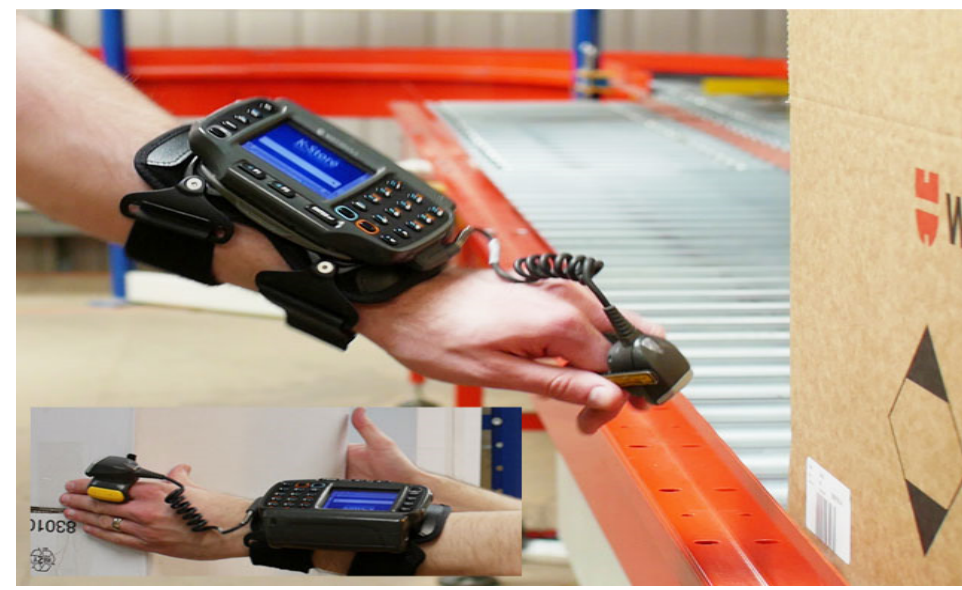
Figure 2. Wireless order picking using bar code technology [31].